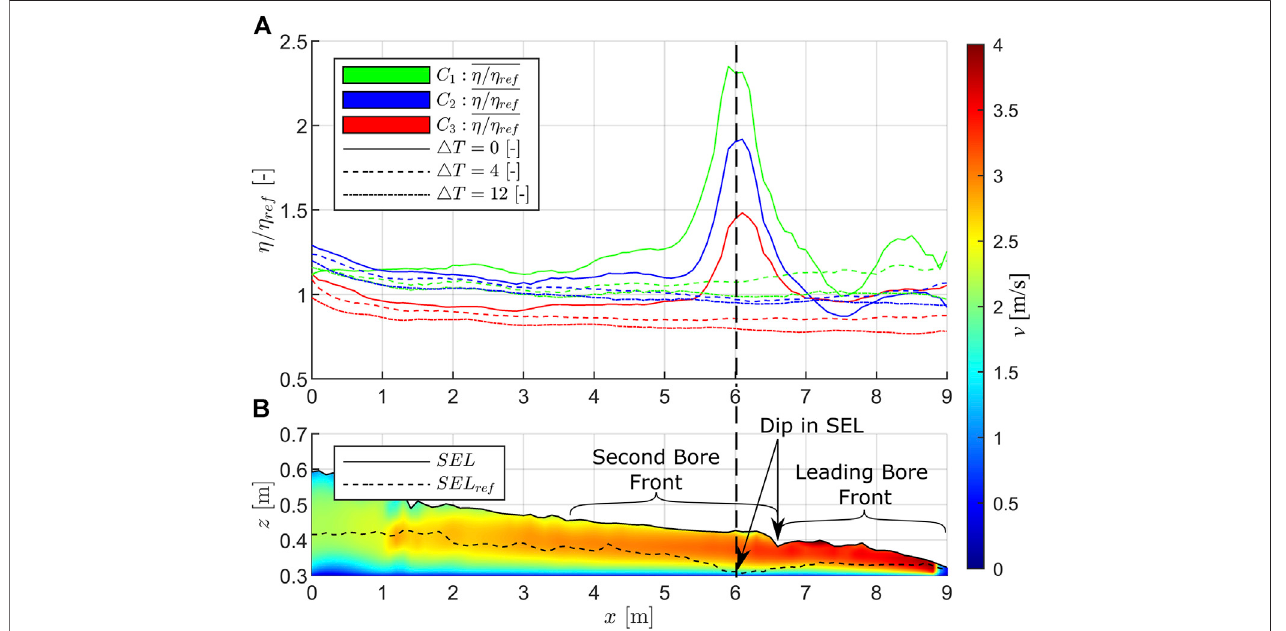
FIGURE10| Visualizationofclass-averagedsurfaceelevationlines(SELs)overspace (A) .Classesareindicatedbycolorandinstantsintimebylinetype.Local fl ow velocities (B) are color coded according to the color bar, Reference SEL by a dashed line. Dimensionless time steps Δ T describe the additional time after wavefront fi rst reached the end of the horizontal plane at x (cid:1) 9 m .